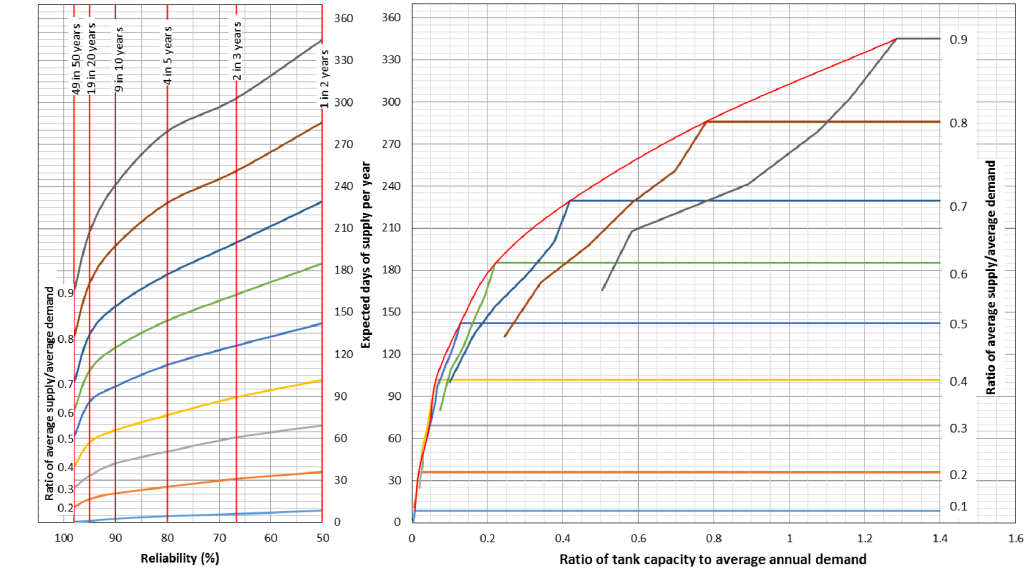
Figure 4. Generalised rainwater harvesting design and assessment charts for